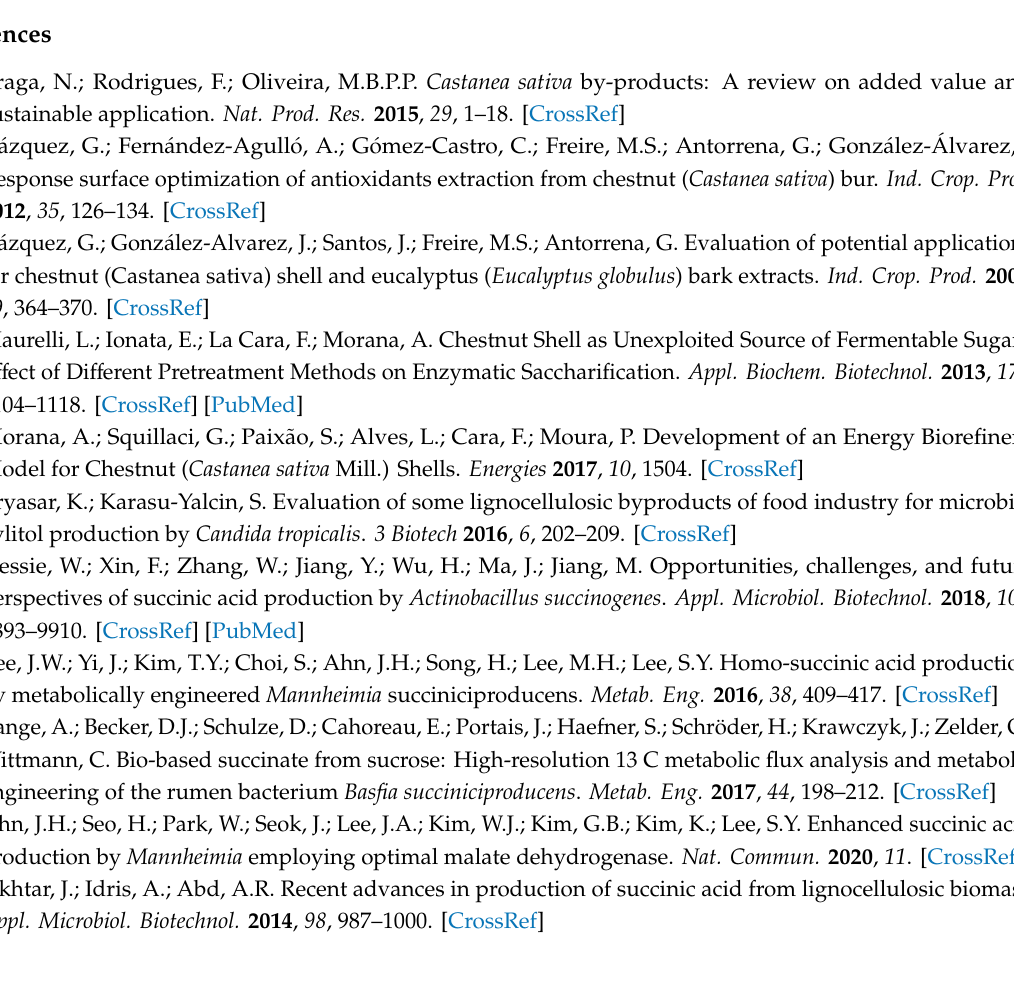
Figure S1: Growth of A. succinogenes in 0.1 L bottle experiments. Experiments were conducted on MH medium ( a ) and ( c ), and on 90% v / v CSH hydrolysate supplemented with glucose up to 12 ± 1 and 18 ± 2 g / L. Curves indicate consumption of glucose and citrate, production of acids and pH measurements during the cultivation. Figure S2: Growth of A. succinogenes in 0.1 L bottle experiments. Experiments were conducted on MH medium with about: ( a ) 50 g / L of glucose and 50 g / L of MgCO 3 , ( b ) 20 g / L of glucose and 20 g / L of MgCO 3 and ( c ) 10 g / L of glucose and 10 g / L of MgCO 3 . Curves indicate consumption of glucose and production of acids and biomass during the